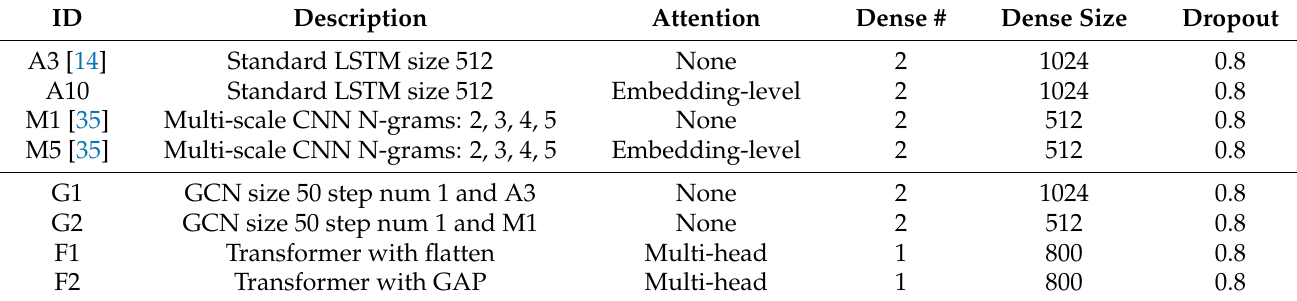
Table 1. Proposed architectures. ID is the architecture identifier. Description is a brief explanation of the underlying model. Attention describes the type of attention mechanism used in the model. Dense # is the number of fully connected layers with a ReLU activation (all the architectures have a final fully connected layer with a softmax activation). Dense size is the size of the fully connected layers with an ReLU activation. Dropout is the value of the dropout